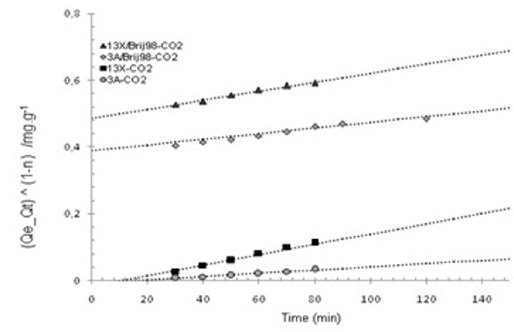
Figure 7. Carbon dioxide kinetics adsorption onto purely silica at 298K (solid points: experimental; dashed lines: